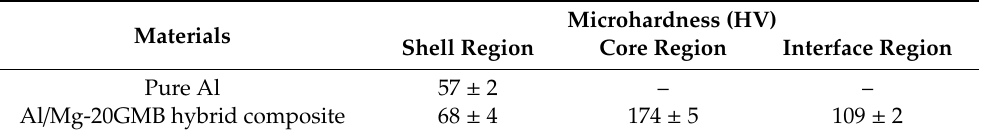
Table 2. Microhardness values for as-cast